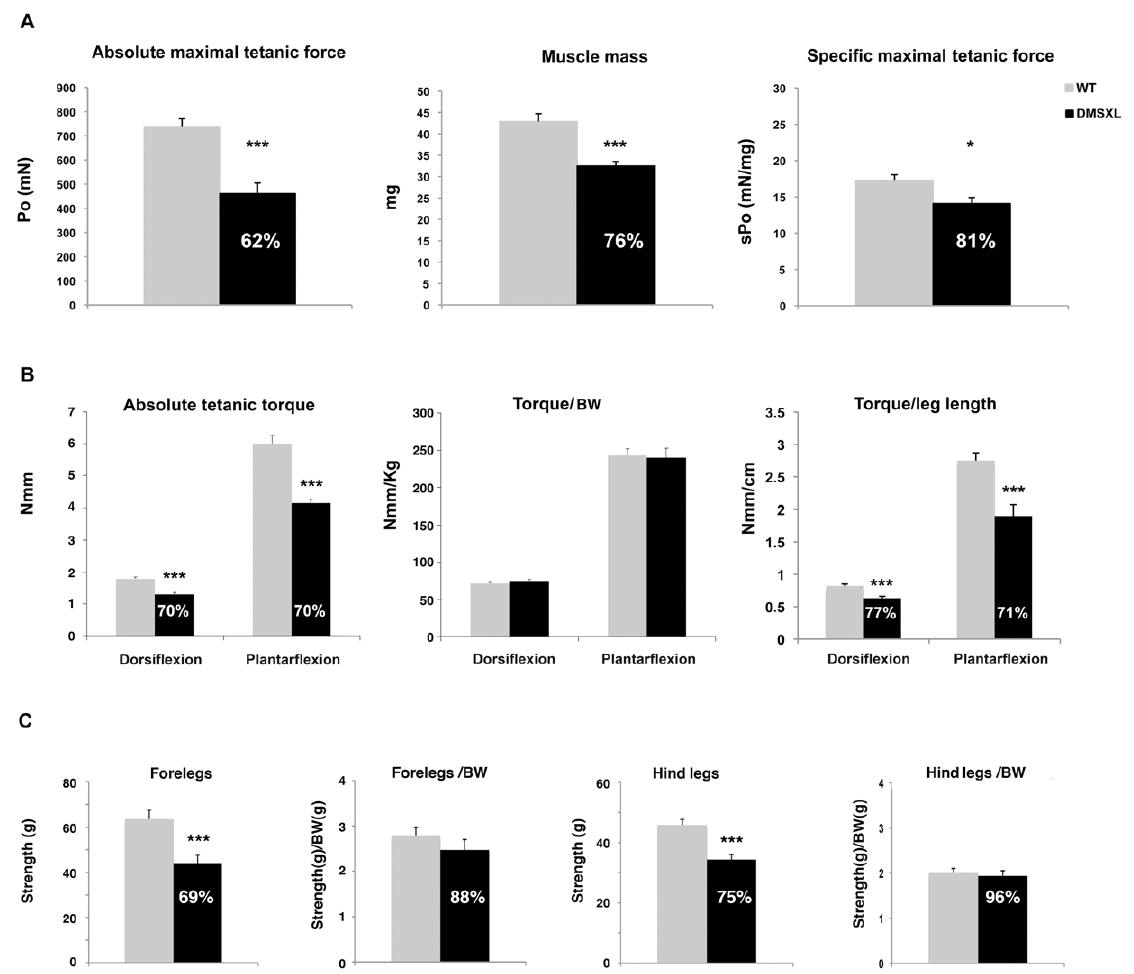
Figure 11. Muscle force and strength measurement in DMSXL mice. (A) Absolute maximal tetanic force was measured in situ for WT and DMSXL female mice between 4 and 6 months of age, as well as muscle mass. The specific maximal tetanic isometric force represented the absolute maximal tetanic isometric force normalized to the muscle mass, n=8 biological replicates in both groups. (B) Absolute tetanic torque dorsiflexion and plantarflexion in WT and DMSXL mice were determined using a home built dynamometer. Absolute tetanic torque normalized to mouse weight or leg length are also shown, n=8 for both groups. (C) Grip strength was measured with a grip dynamometer in WT and DMSXL forelegs and hind legs and normalized to body weight. n=22 biological replicates in both groups. Data are presented as means 6 SEM (* p , 0.05, ** p , 0.01, ANOVA, Student’s t test). The mice were analyzed between 4 and 5 months of age. BW: Body weight.